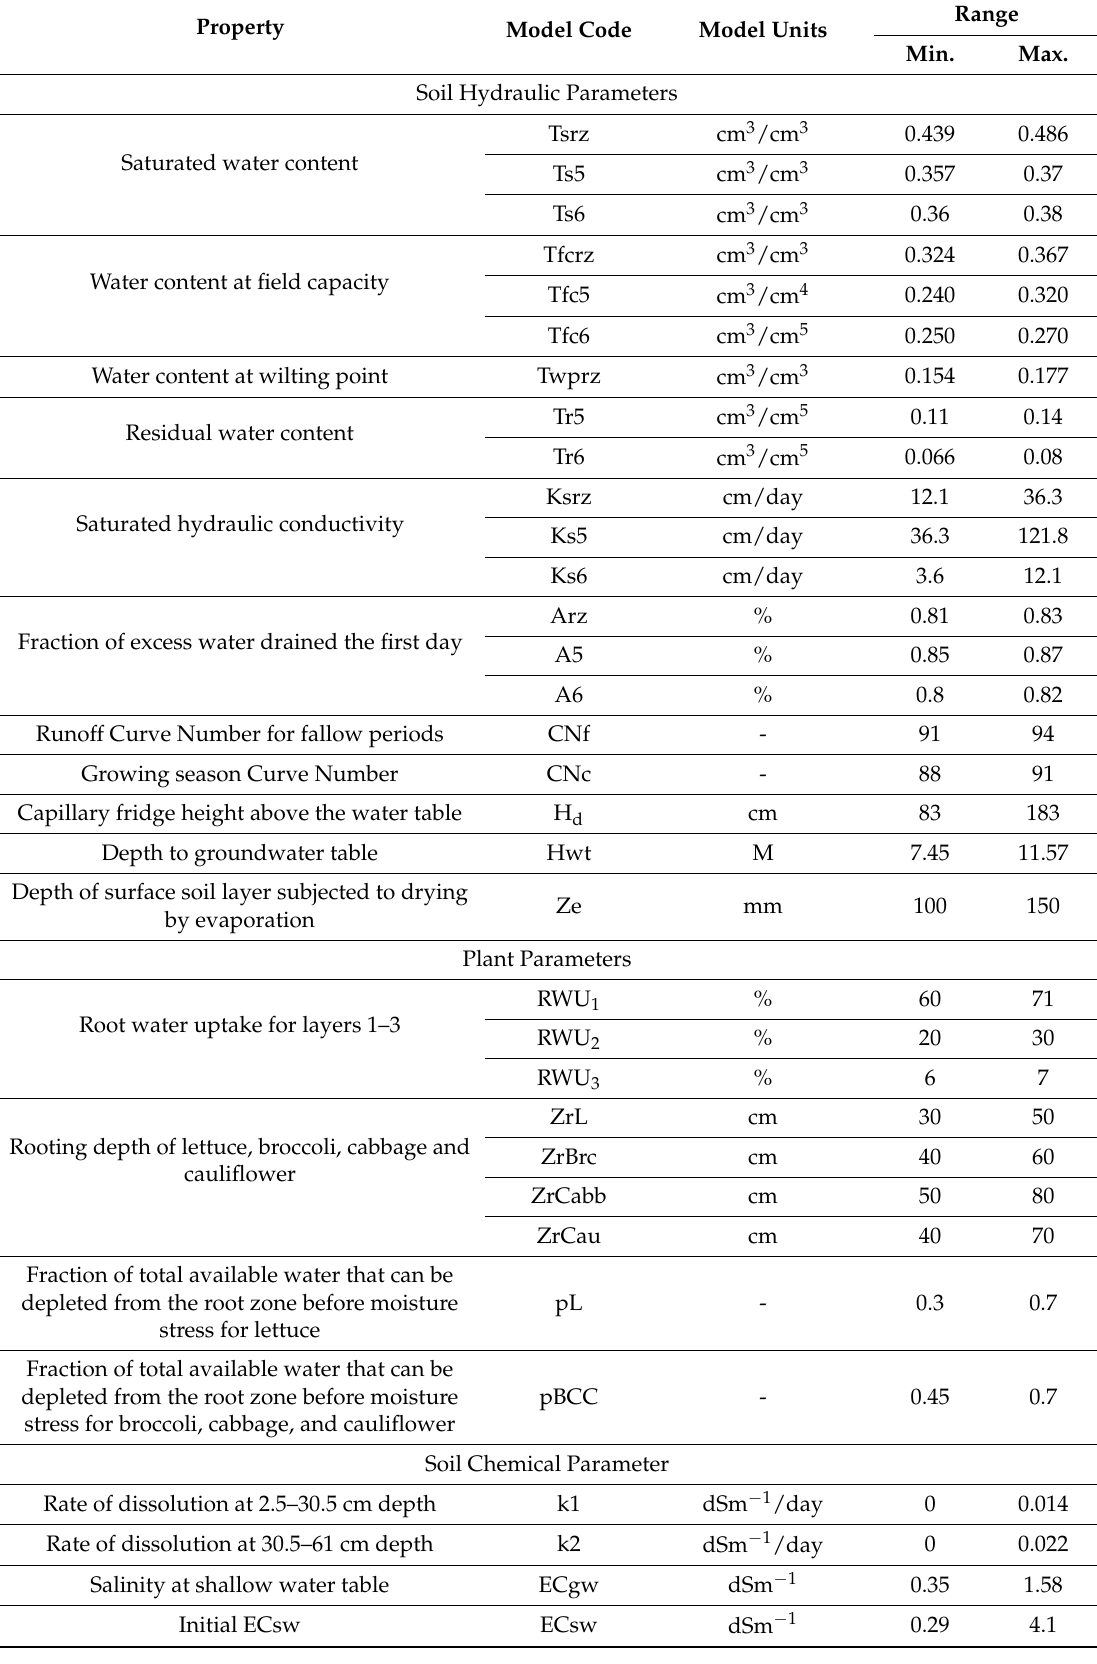
Table 3. Model parameters used in the sensitivity analysis. (Note: rz—root zone layers 1–4; 5—unsaturated zone layer 5; 6—unsaturated zone layer